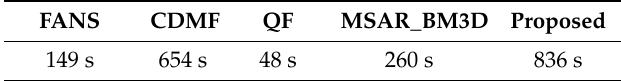
Table 7. Computational time (in seconds) for filtering the 1000 × 1000 × 13 SAR